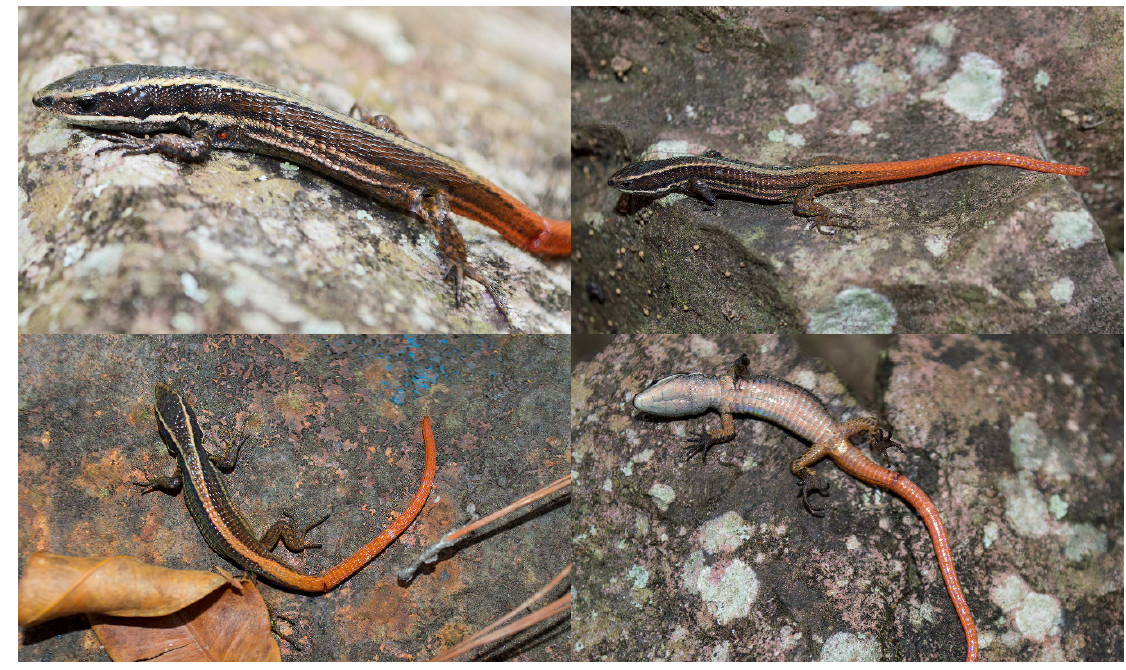
Figure 7. Live specimen of Cercosaura pacha sp. nov., subadult female MUBI 14512 (paratype, SVL